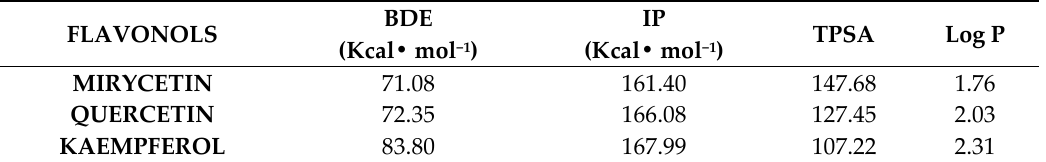
Table 4. Binding dissociation enthalpy ( BDE), ionization potential (IP), topological polar surface area (TPSA), and partition coefficient octanol/water (log P) of flavonols.